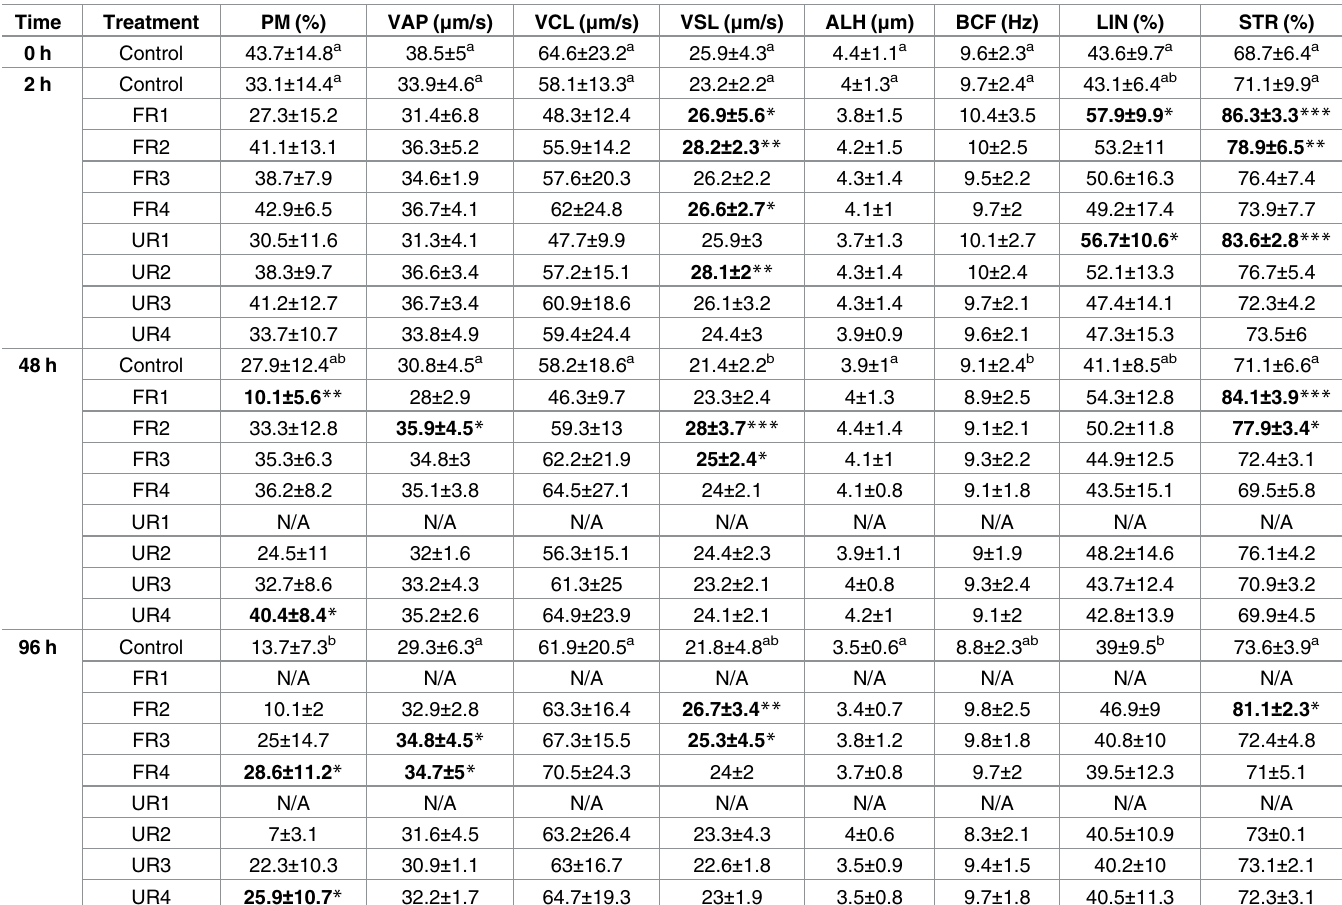
Table 2. Sperm motility parameters in samples with or without rooibos extractsupplementation during boar semen storage at 17˚C. Time